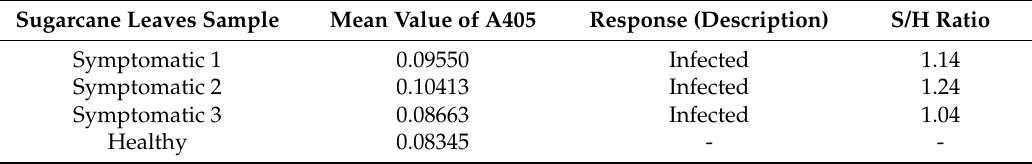
Table 2. DAS-ELISA analysis for detection of the SCMV infection in sugarcane leaves. The ELISA analysis was conducted using an ELISA reagent set for SCMV (Agdia, Inc., Elkhart, IN, USA) and a three times diluted crude extract of sugarcane